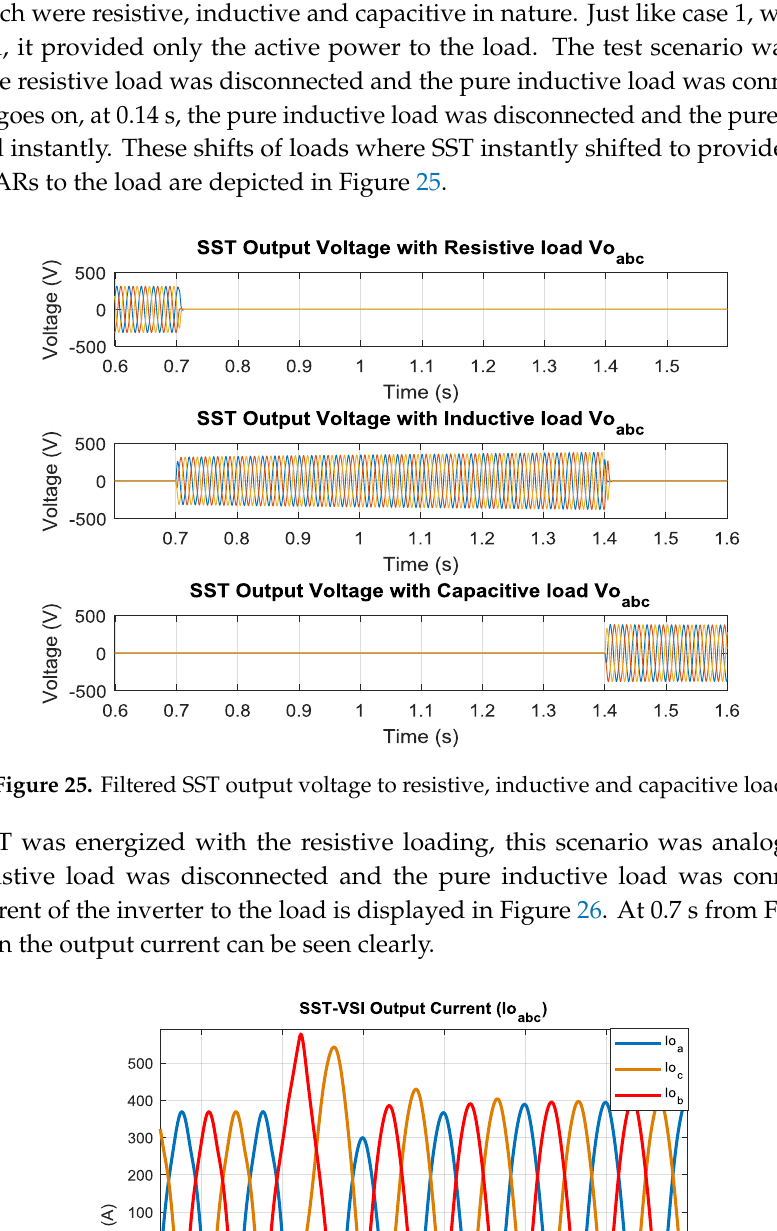
Figure 24. SST-VSC response working as the PFI device with induction motor loading.